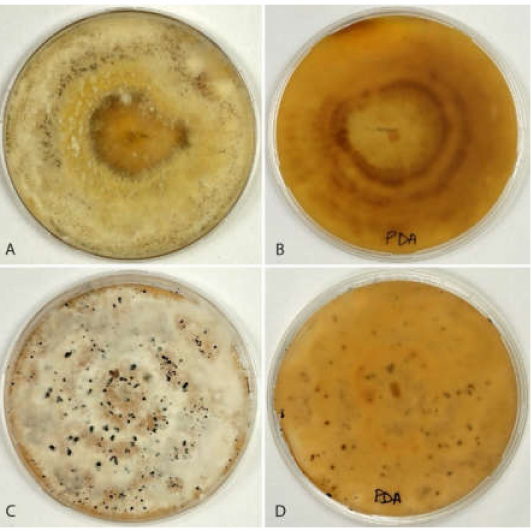
Figure 8. Cultures of Neopestalotiopsis spp. from avocado on PDA after 4 weeks. ( A , B ) N. rosae isolate AC50 from top ( A ) and reverse ( B ); ( C , D ) N. siciliana isolate AC46 from top ( C ) and reverse ( D ). Habitat . On stems of Persea americana